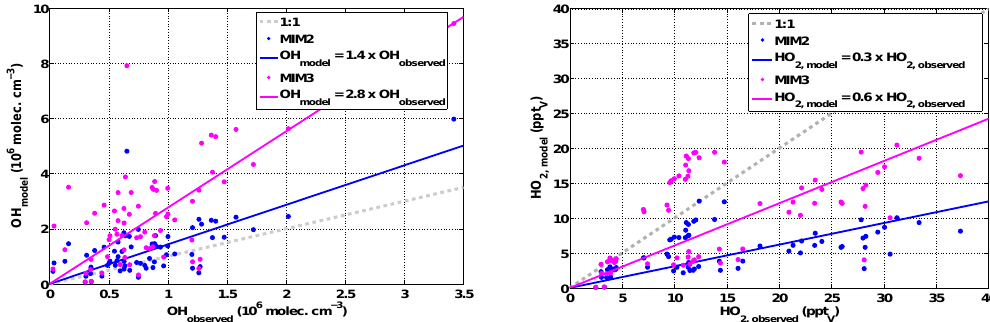
Fig. 11. Simulated vs. observed OH concentrations and HO 2 mixing ratios, applying the MIM2 chemistry scheme and the recently proposed MIM3 including new additions in the isoprene chemistry.